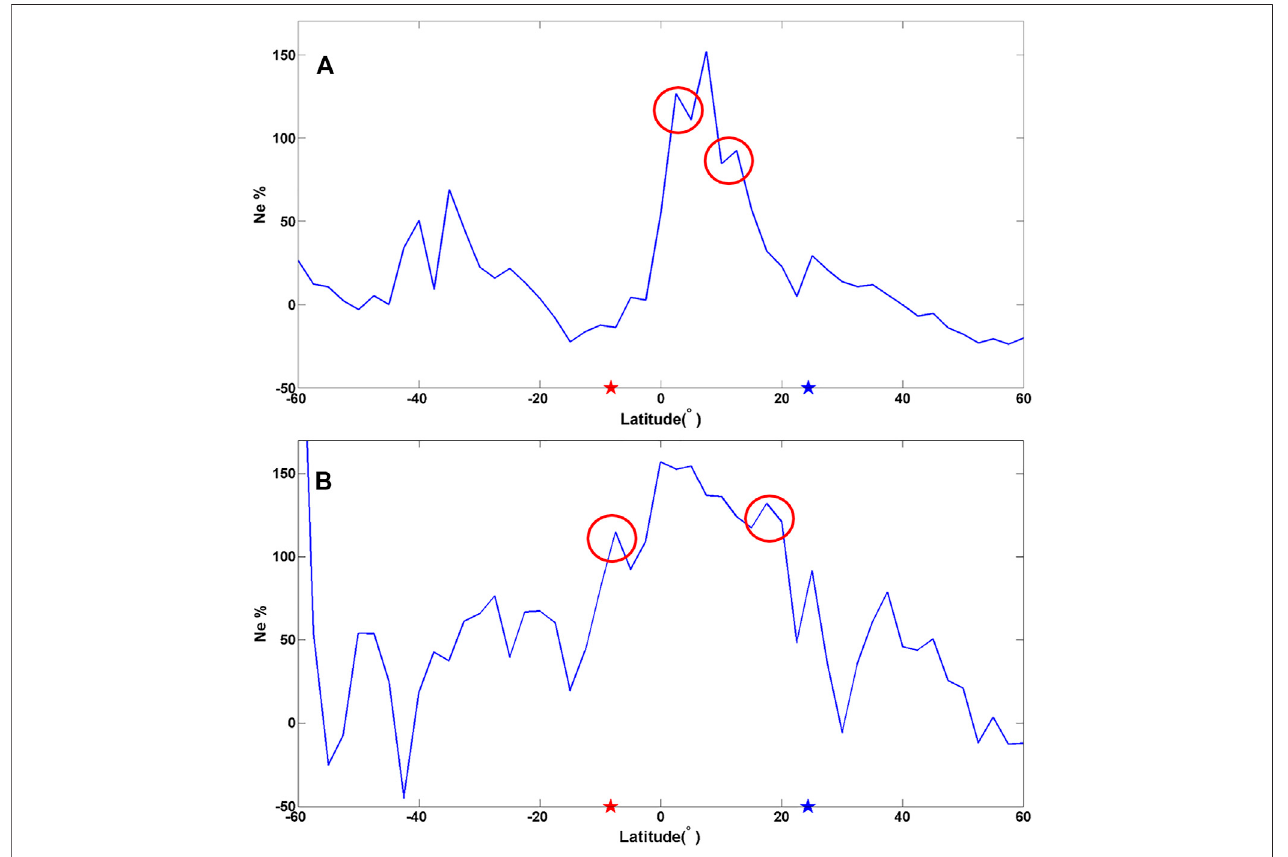
FIGURE 15 | Ne relative change along orbit in the daytime (A) and nighttime (B) on 31 July 2018. The red and blue stars represent the epicenter and its conjugate point, respectively.